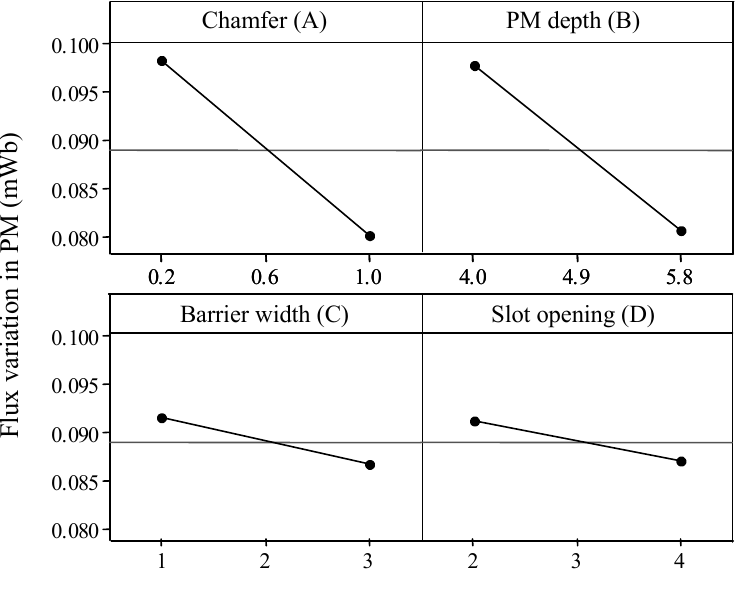
Figure 7. Main e ff ect plots for objective Figure 7. Main effect plots for objective function. Figure 7. Main effect plots for objective function.